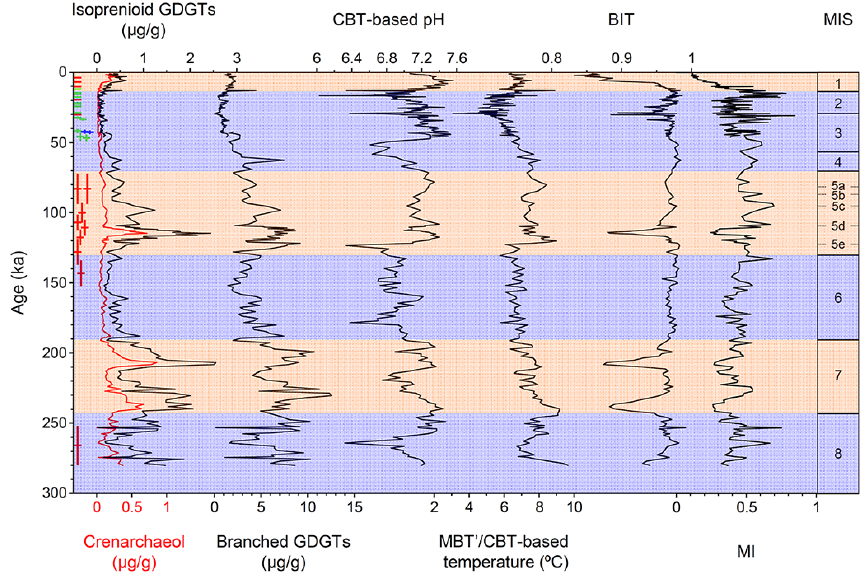
Figure 6. Variations in the concentrations of total isoprenoid and branched GDGTs and crenarchaeol, CBT-based pH, MBT 0 /CBT-based temperature and BIT and MI in cores BIW07-6 and BIW08-B during the last 280,000 years. Red, blue, and green bars indicate age controls with 95% confidence intervals of volcanic ashes, the 14 C of plant debris and total organic carbon, and ARM events,